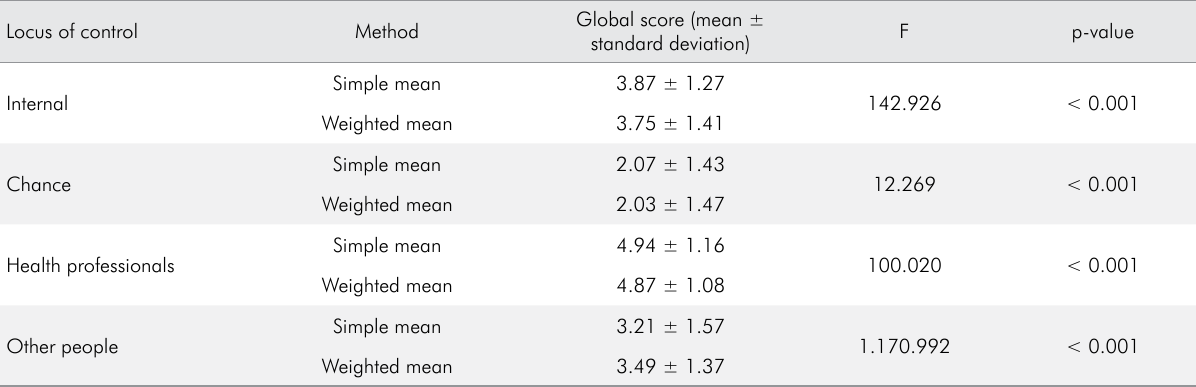
Table 6. Comparison of global scores for the factors of the Multidimensional Health Locus of Control - Form C (MHLC-C) obtained with the simple mean and the weighted mean.